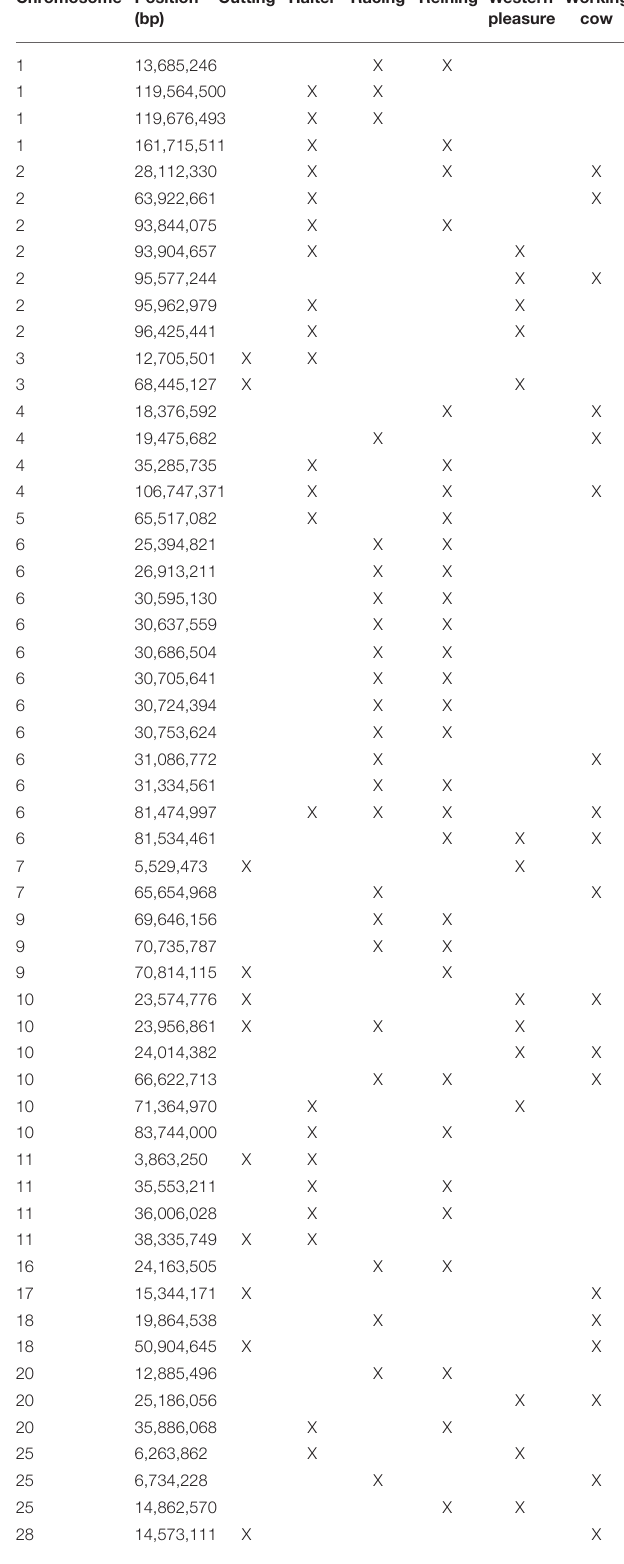
TABLE 2 | ROI identified by d i analysis in the 6 QH subpopulations. QH subpopulation